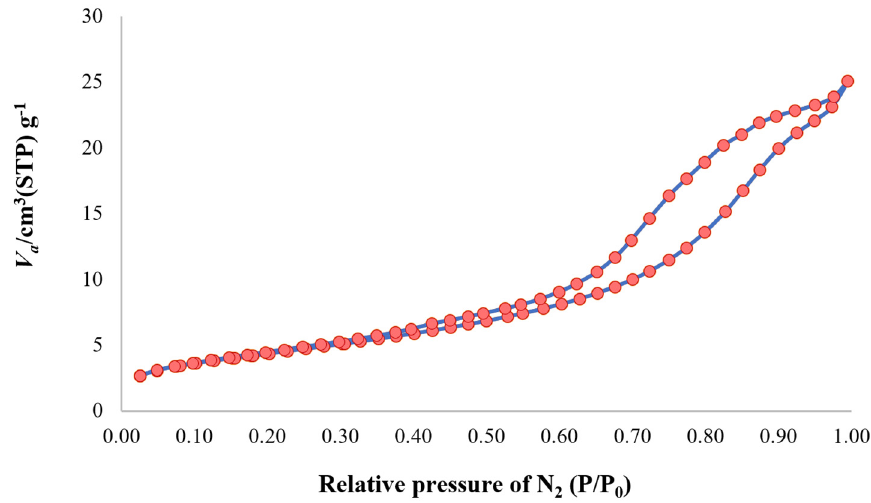
Figure 6. Nitrogen physisorption isotherms for ball-milled Fe/TiO 2 –7. Table 1. Surface properties of the rutile TiO 2 and produced Fe/TiO 2 catalysts. Catalysts BET Surface Area